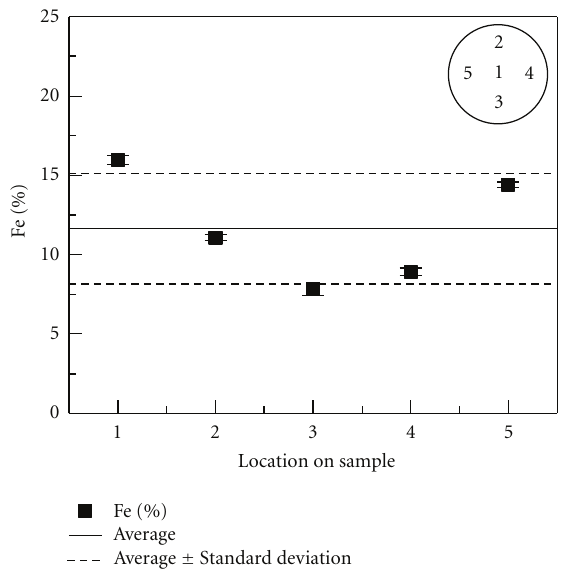
Figure 3: The iron content (percent by weight, Fe/(Ni + Fe) × 100%,) for five locations on one electrodeposited sample deter- mined by PIXE. The NiFe thin film was deposited from a 100mM NiSO 4 , 10mM FeSO 4 , 0.5M H 3 BO 3 , and 1M Na 2 SO 4 solution at − 1000mV for 6min. A sketch of the di ff erent locations on the sample is included in the inset. The unweighted average of the results is indicated by the solid line while the dashed lines represent the average plus and minus the standard deviation.